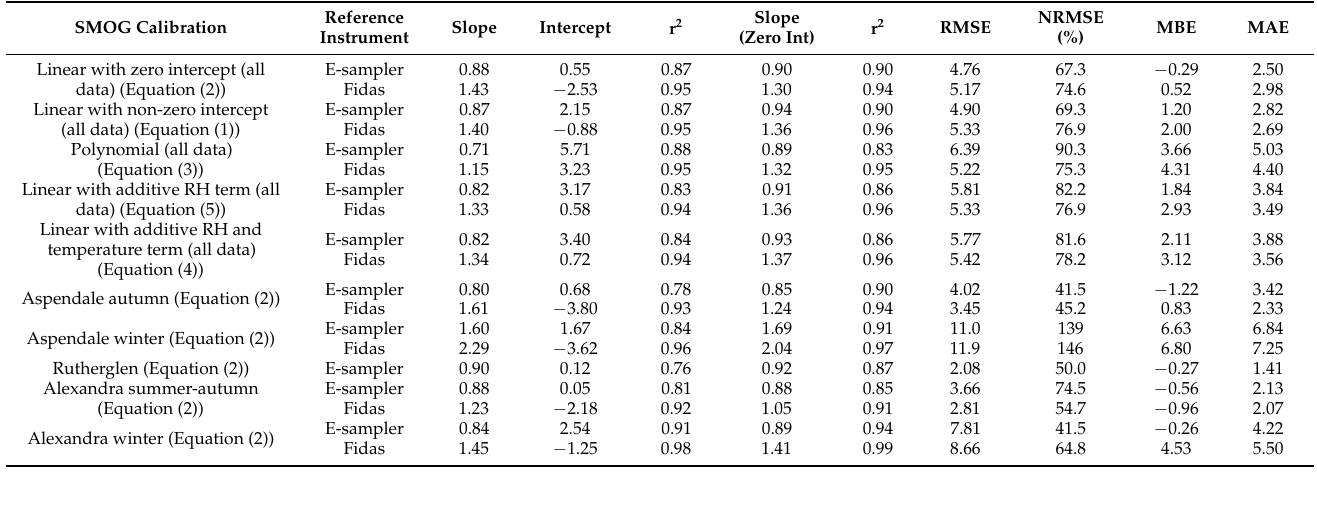
Table 4. Performance of calibrated SMOG units in comparison to gravimetrically corrected reference instruments.